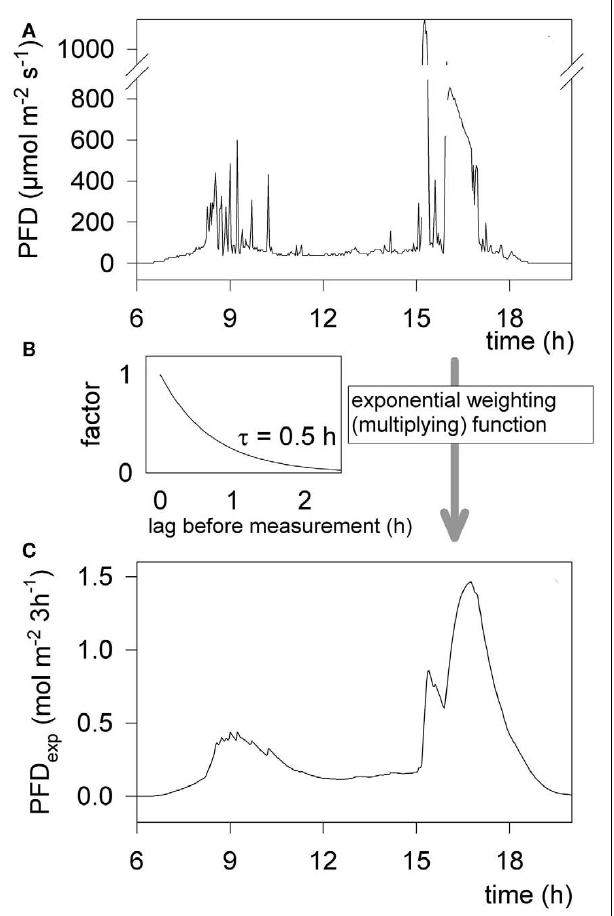
FIGURE 2 | Light intensity (PFD) recorded on three subsequent days with three parallel sensors, which were located on the same side of the trunk within the canopy. (A) Light sensor located on vertical branch, about 40cm off the main trunk. (B) Light sensor located on the same vertical branch, but 2m off the main trunk. (C) Light sensor located 3m just above sensor A, on vertical branch, about 40cm off the main trunk.